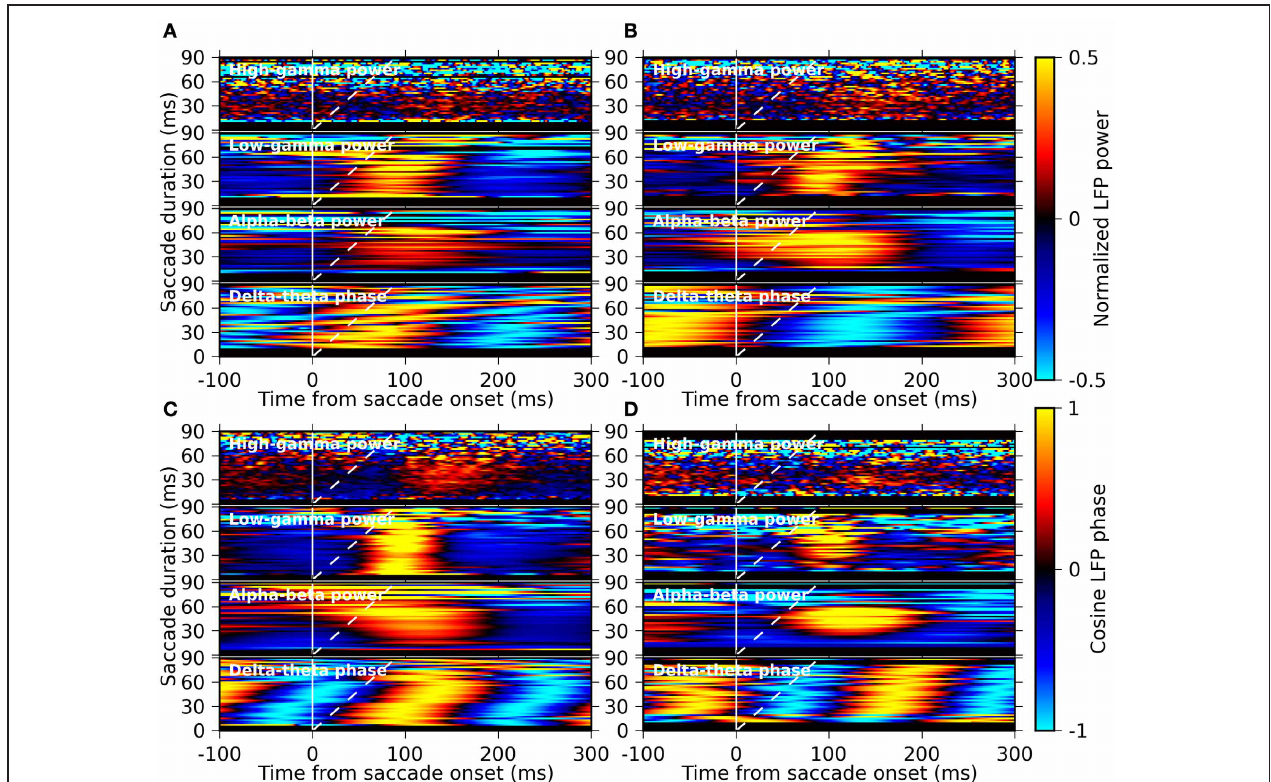
from bottom to top, respectively. The averages were computed separately for sets of saccades with different saccade durations (bin width: 2ms), constituting the y-axis of each plot in pseudo-color (color bars on the right). The solid and dashed white lines indicate the timing of saccade-onset and fixation-onset, respectively, at each vertical position within each